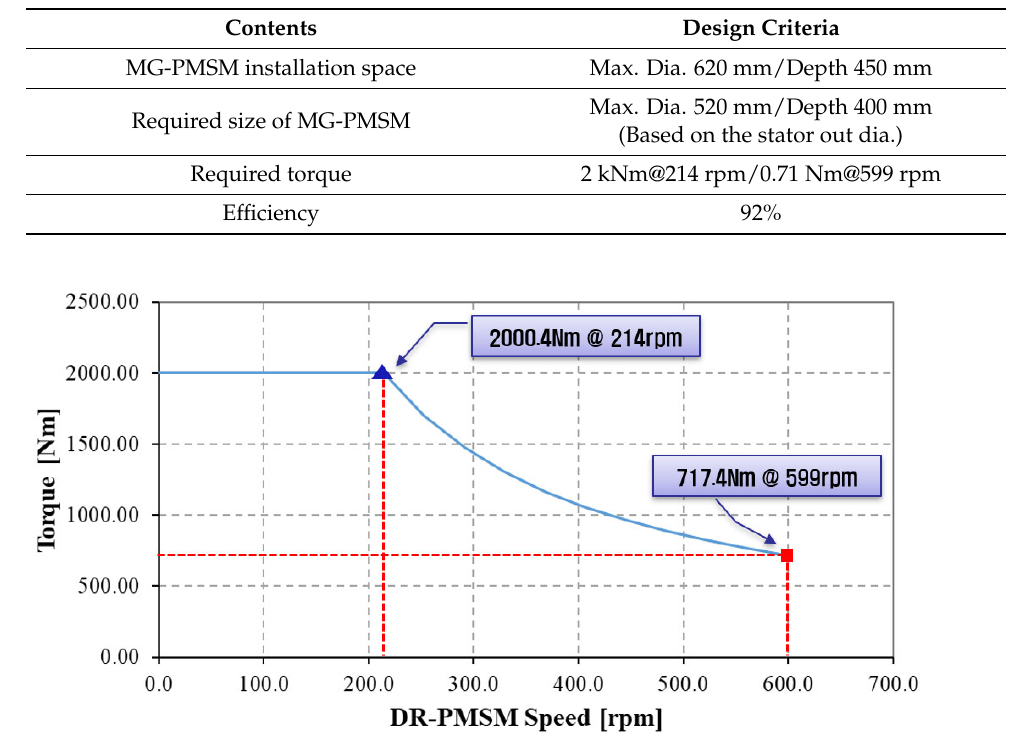
Figure 5. Required torque-speed curve of the low-speed part (Wheel side) on the 45kW-class driving system for the Korean tram.